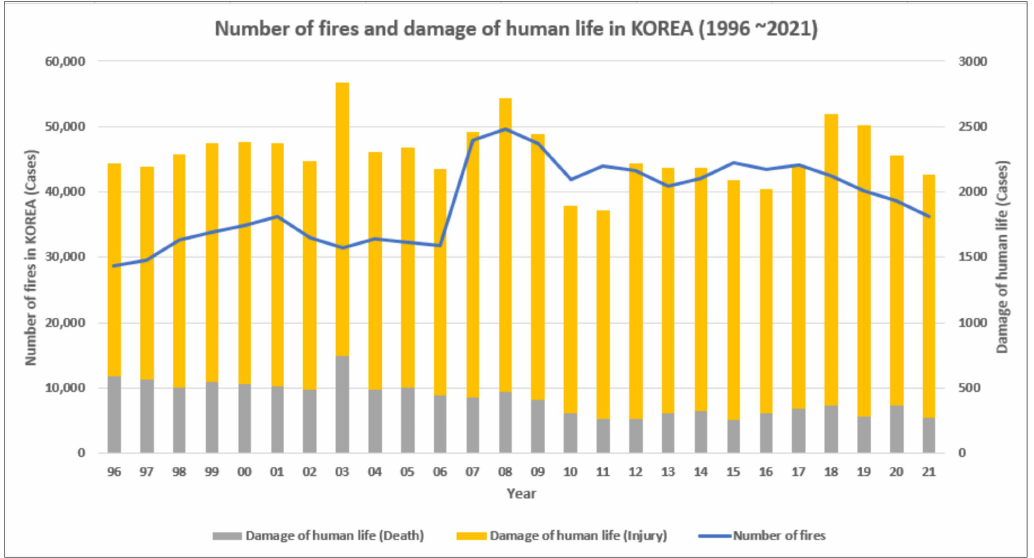
Figure 1. Number of fires and damage to human life in ROK